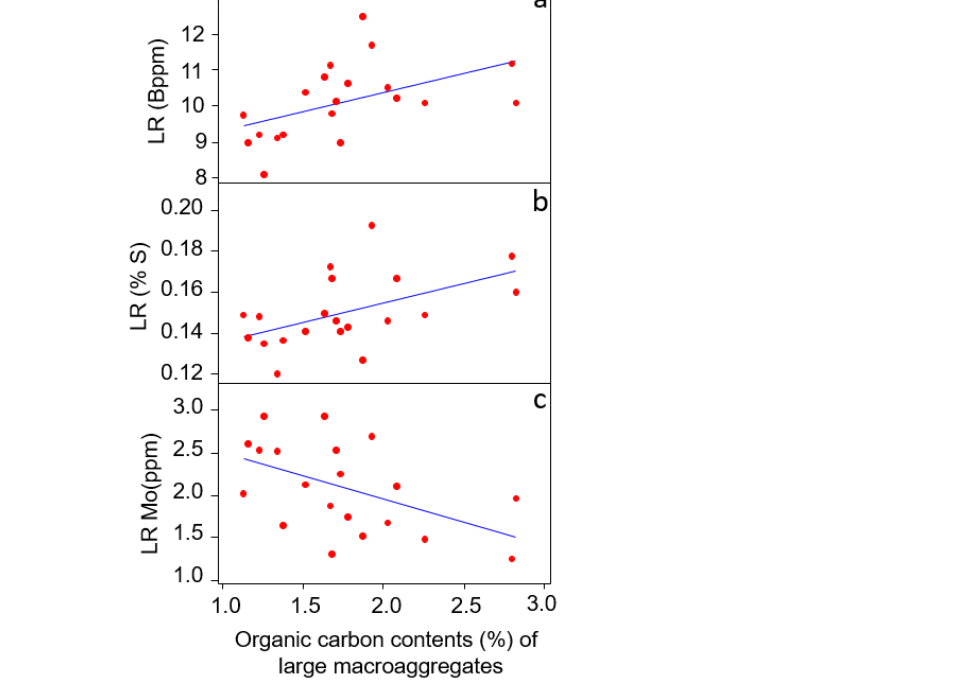
Table 2. Relationship between abundance of small macroaggregates (<2000 – 500 μm) and plant traits. Small Macro-Aggregates (<2000 – 500 Linear Regression Coefficient (R 2 ) Probability Value (P) Relationship μm) Plant traits Up trichome R 2 = 0.28 p = 0.024 - Down trichome R 2 = 0.24 p = 0.023 - Shoot traits Shoot S content (%) R 2 = 0.21 p = 0.043 +